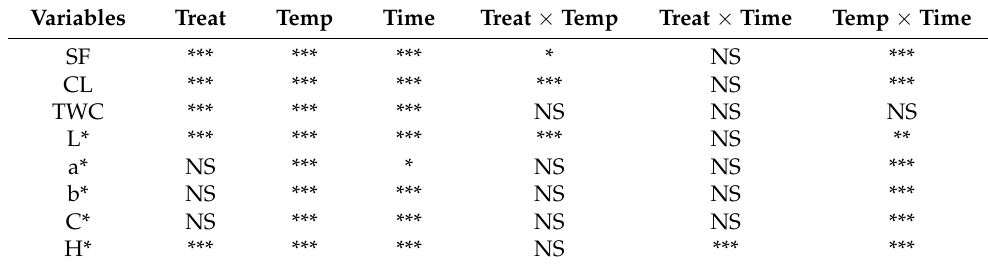
Table 1. Statistical analysis of the simple effects of the factors (tumbling process (Treat), cooking temperature (Temp), and cooking time (Time)) and their cross-effects (Treat × Temp, Treat × Time, and Temp × Time) on values of shear forces (SF), cooking losses (CL), total water content (TWC), lightness (L*), redness (a*), yellowness (b*), chroma (C*), and hue angle (H*) evaluated on sous-vide cooked bovine Semitendinosus muscle samples. NS = not significant, * p < 0.05, ** p < 0.01, *** p <